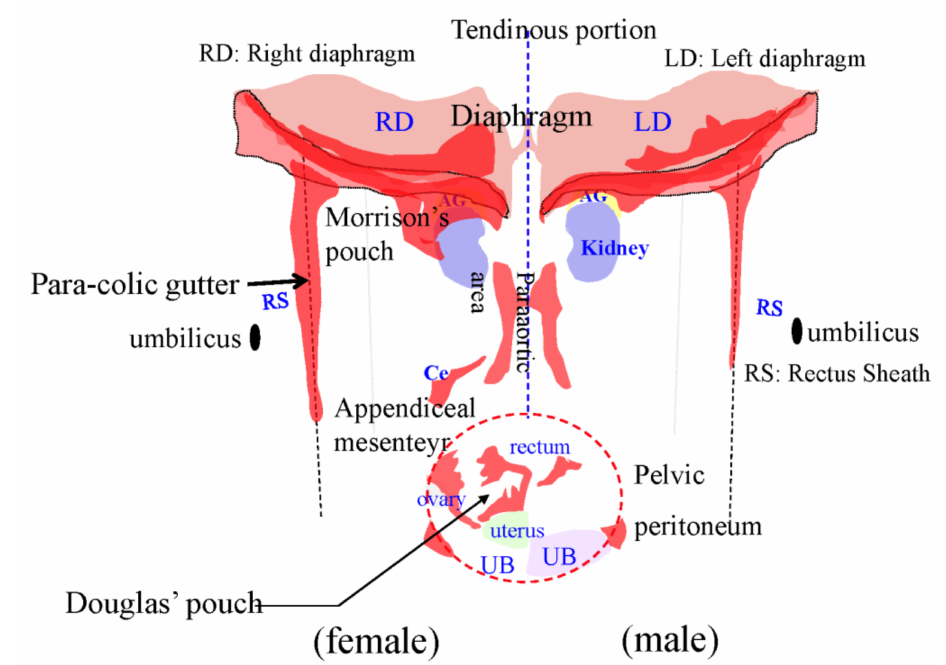
Figure 23. Schematic shows the initial lymphatic vessel-rich peritoneal sectors (pink-coloured sectors).